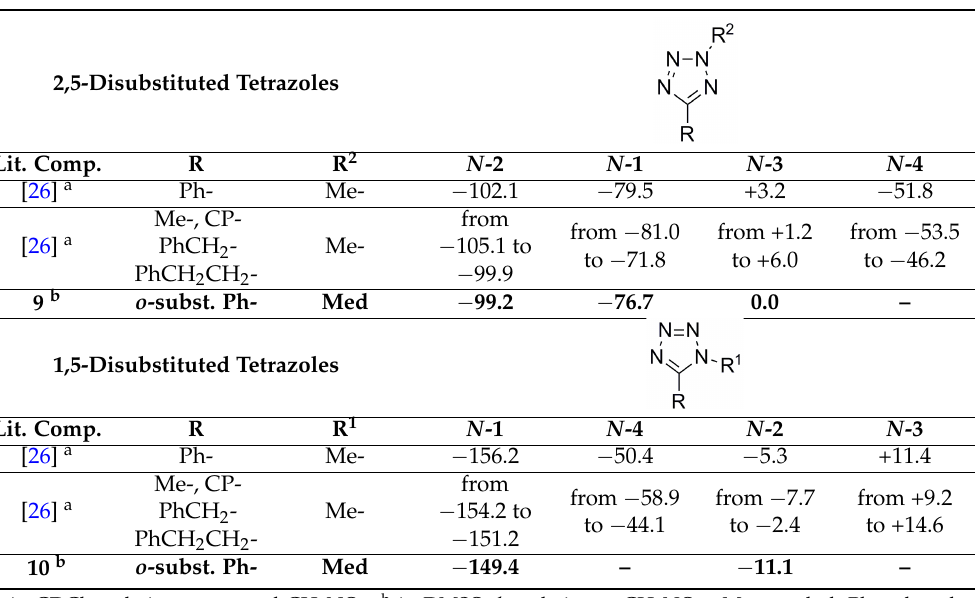
Table 5. Comparison of 15 N-NMR data for some 2,5- and 1,5-disubstituted tetrazoles.